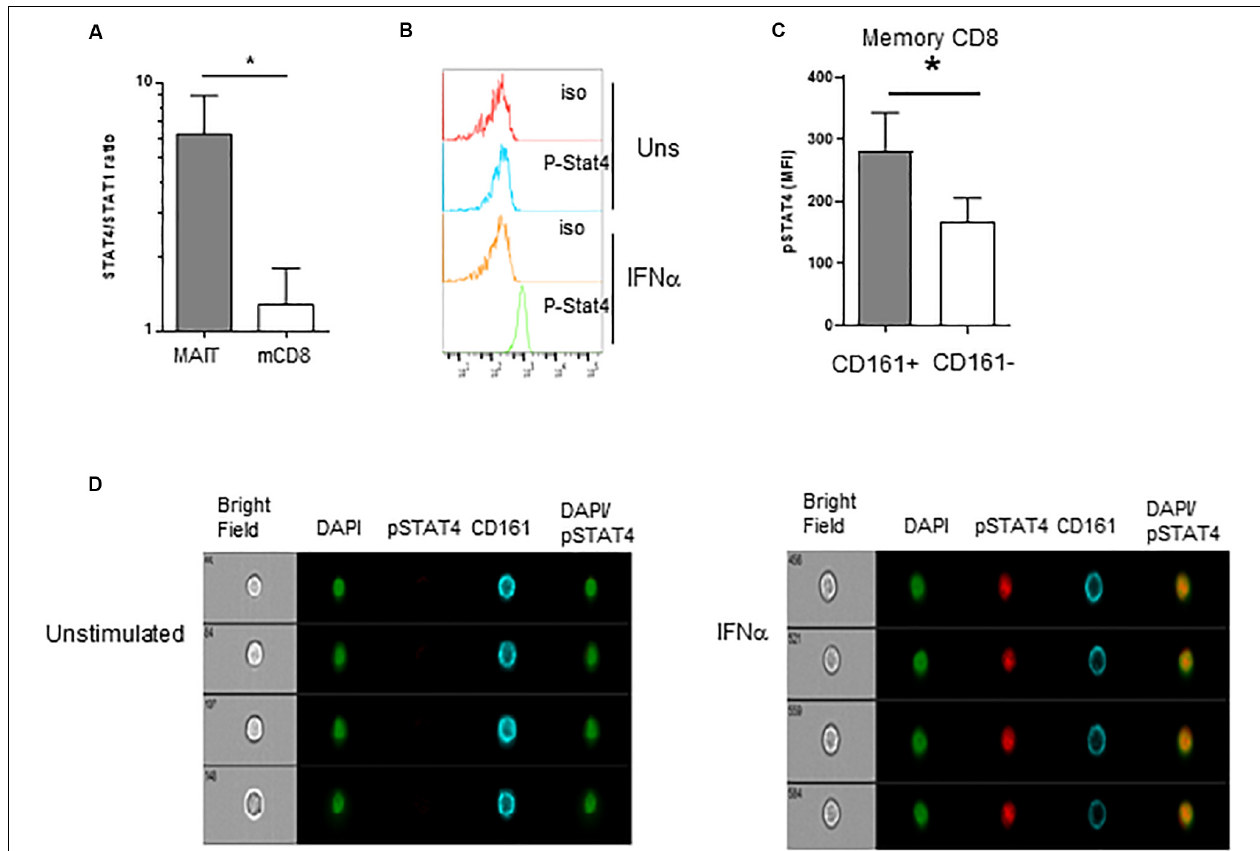
FIGURE 5 | Preferential usage of the STAT4 pathway by IFN α -stimulated MAIT cells. (A) Ratio of STAT4 to STAT1 mRNA expression in purified MAIT cells and conventional memory CD8 T cells, determined by quantitative RT-PCR, N = 4. (B) Representative flow cytometry histograms of phospho-stat4 expression by MAIT cells left unstimulated or after IFN α 2b stimulation. (C) Cumulative data (mean ± SEM) of MFI of pSTAT4 staining in MAIT and conventional memory CD8 T cells, after IFN α 2b stimulation. Mann–Whitney test was used to compare frequencies. n = 6; * p < 0.05. (D) Representative example of flow imaging data, showing pSTAT4 and CD161 expression in CD161 + CD8 + MAIT cells, left unstimulated (left panels) or after IFN α 2b stimulation (right